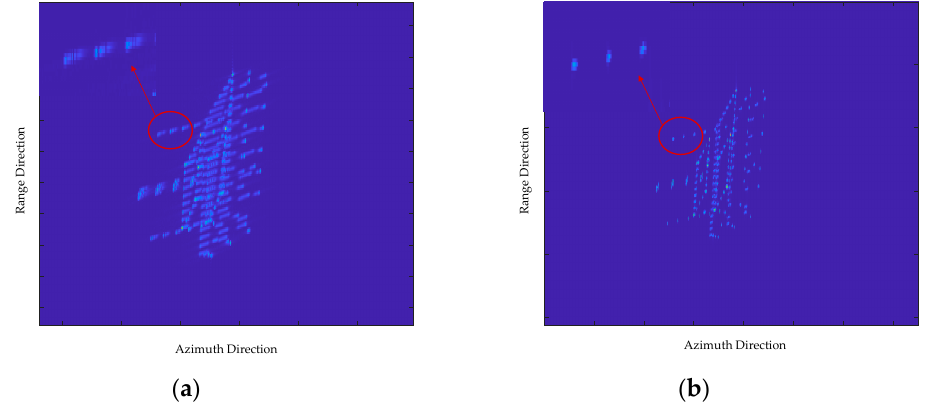
Figure 12. Comparison of the PGA algorithm and the presented method of the simulation experiment results: ( a ) Refocusing result of the ship target obtained by the PGA algorithm; ( b ) Final refocusing result of the ship.